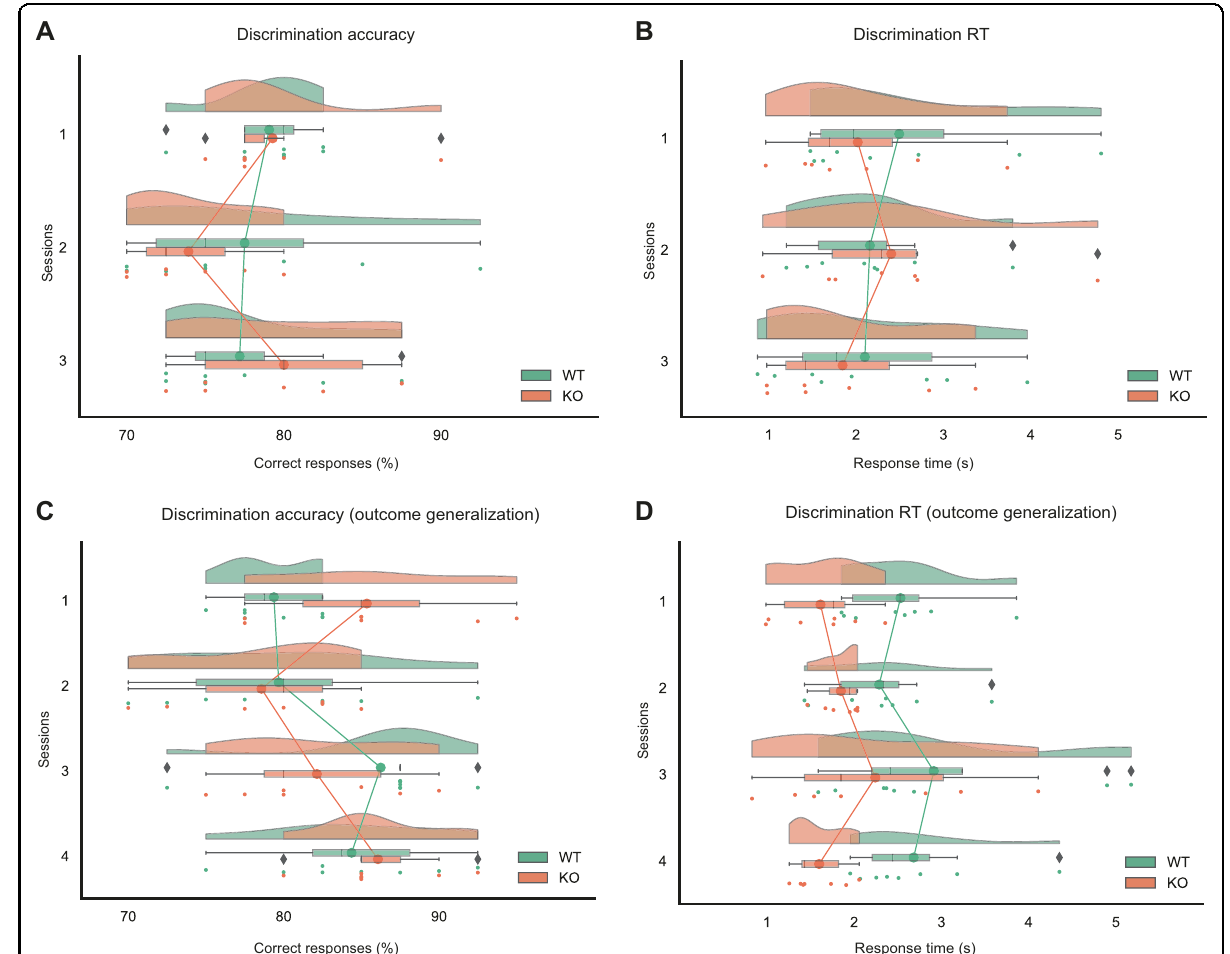
Fig. 3 Discrimination with and without the change in reward contingencies (accuracy ≥ 70%). A , B Discrimination performance without a change in reward contingencies. A Discrimination accuracy. Percentage of correct responses across the last three sessions. The discrimination accuracy stayed similar as the session progressed in both WT and KO rats. There was no signi fi cant difference in correct responses across the last three sessions between them. B Discrimination RT. The response time stayed similar as the session progressed in both KO and WT rats. There was no signi fi cant difference in RT across the sessions between them. C , D Discrimination performance when probabilistic reward contingencies were reduced (outcome generalization). C Discrimination accuracy. Percentage of correct responses across sessions. No signi fi cant difference between KO and WT rats, and no signi fi cant difference across sessions. D Discrimination RT. The RT was signi fi cantly lower in KO than WT rats. There was no signi fi cant effect of the sessions. Note: WT ( N = 7); KO ( N = 8); the points between solid lines represent the mean of the group; the dots represent individual data; the hills represent the probability distribution of the individual data; the range of the colored box represents the interquartile range; the vertical line in the colored box represents the group median; the range of colored box with whiskers on both sides represents the minimum and maximum data range; data outside the whiskers are outliers denoted by the symbol ⧫